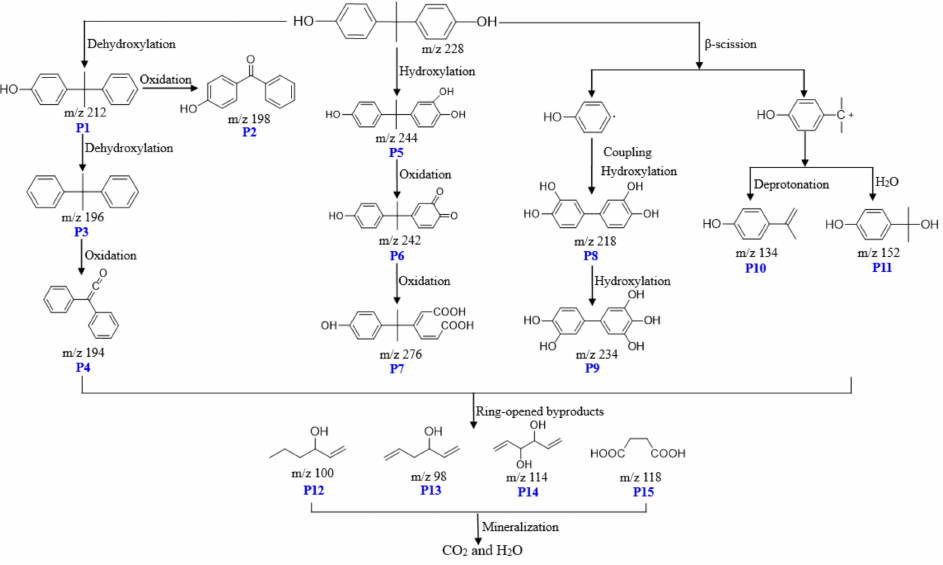
Figure 9. Proposed transformation pathways of BPA in the Mn 2 O 3 /PMS